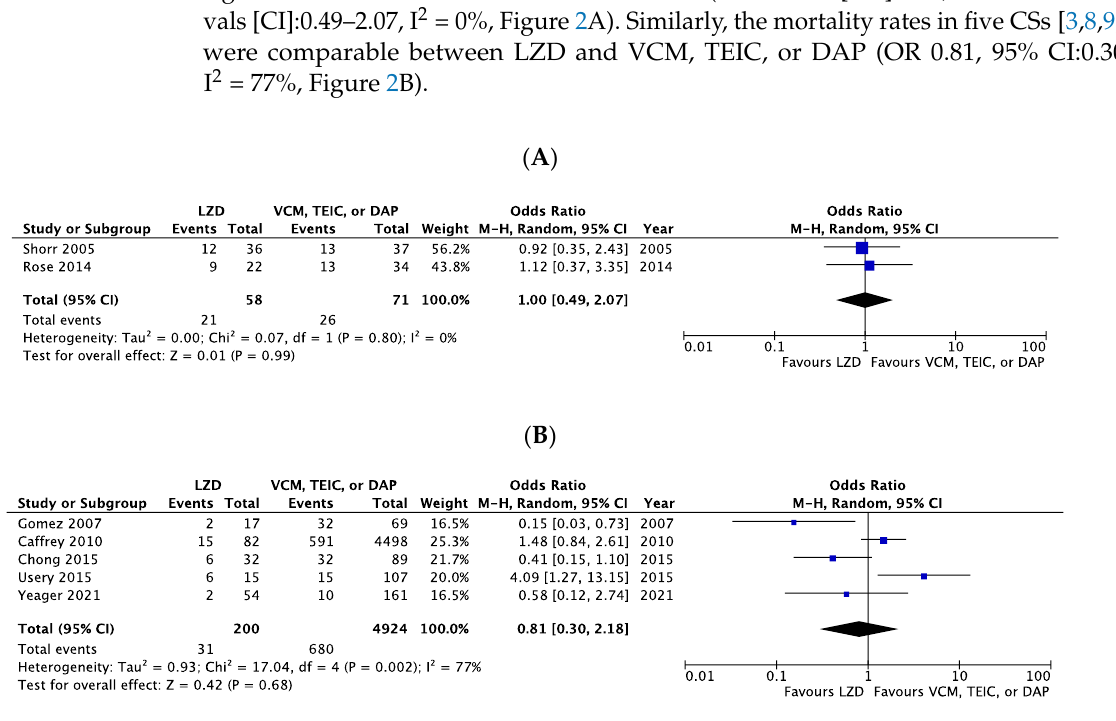
Figure 2. Forest plots of all-cause mortality in patients with MRSA bacteremia treated with LZD versus VCM, TEIC, or DAP. ( A ) RCTs; ( B ) CSs. The vertical line indicates no significant difference between compared groups. Mantel–Haenszel ORs are represented by diamond shapes, and 95% CIs are represented by horizontal lines. Squares indicate point estimates, and the square size indicates the weight of each study included in the meta-analysis. MRSA, methicillin-resistant Staphylococcus aureus ; RCTs, randomized controlled trial; CSs, case-control and cohort studies; CI, confidence interval; LZD, linezolid; VCM, vancomycin; TEIC, teicoplanin; DAP, daptomycin; OR, odds ratio.